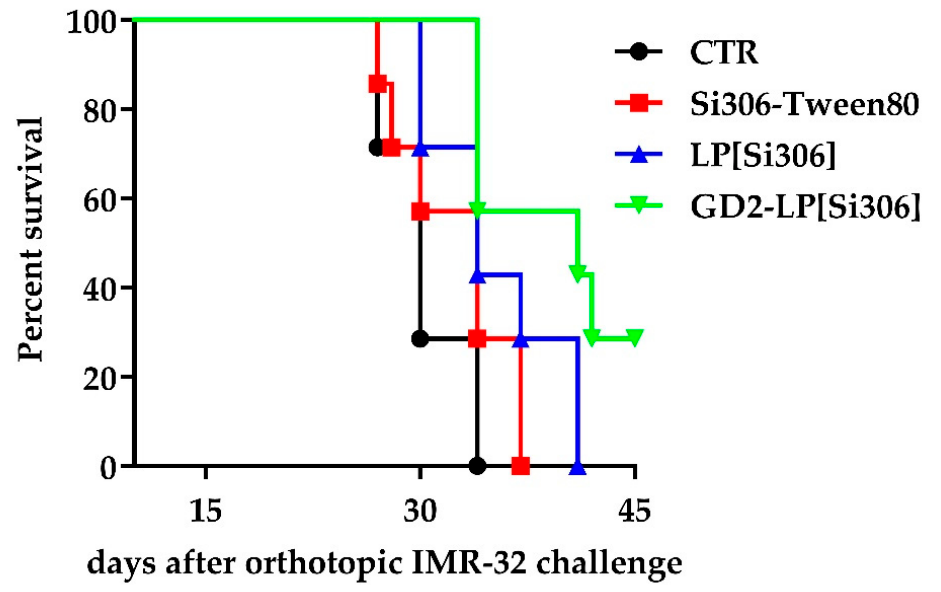
Figure 8. Survival curves of neuroblastoma-bearing mice treated with Si306. Mice were injected in the adrenal gland with IMR-32-luc cells and treated with 25 mg/kg Si306, either free (Si306-Tween80) or encapsulated into untargeted and GD2-targeted liposomes (LP[Si306] and GD2-LP[Si306], respectively), as described in the Materials and Methods section. Survival times of untreated (CTR) and treated mice. Table 5. Median survival days after treatments and statistics between experimental groups. Treated